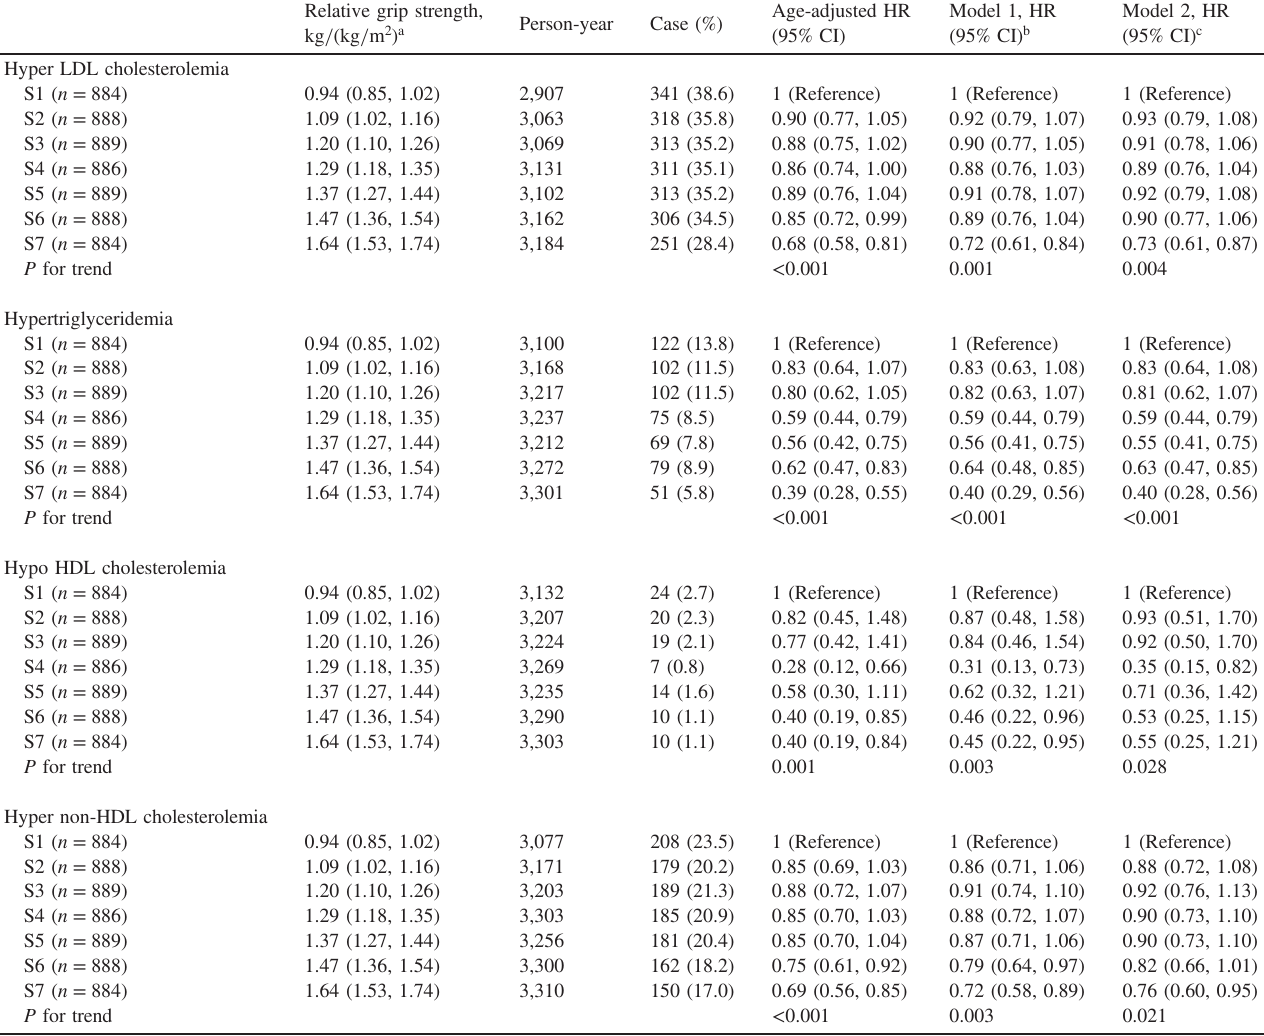
Table 4. Hazard ratios of the incidence of dyslipidemia ’ s components according to septiles of relative grip strength among